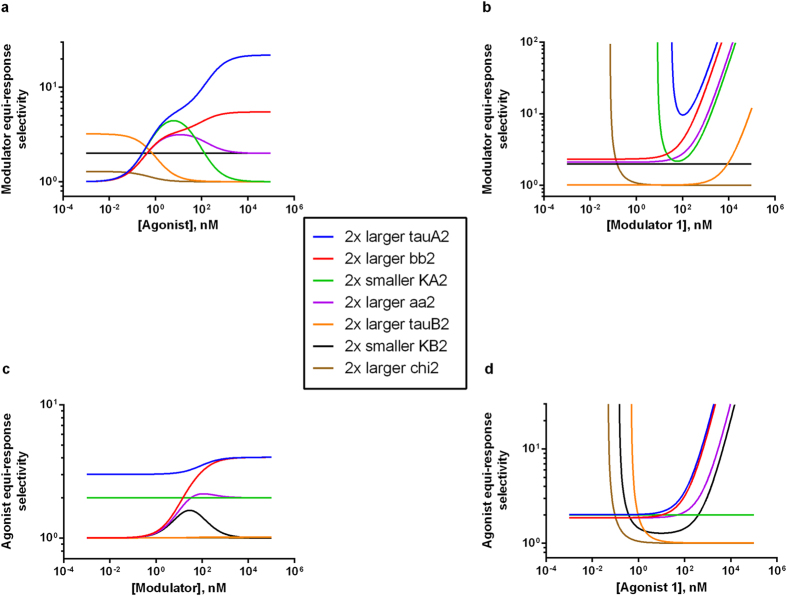
Modulator or agonist equi-response selectivity 2D plots.All simulations for 2D plots of modulator (a,b) or agonist (c,d) equi-response selectivity use the following parameters values (unless indicated otherwise in the label legend): KA1 = KA2 = KB1 = KB2 = 100 nM, chi1 = chi2 = 0.01, tauA1 = tauA2 = 3, tauB1 = tauB2 = 0.1, n1 = n2 = 1, aa1 = aa2 = 2, bb1 = bb2 = 3, RR = 1. (a) Modulator 1 concentration = 100 nM. (b) Agonist concentration = 100 nM. (c) Agonist 1 concentration = 100 nM, (d) Modulator concentration = 100 nM.